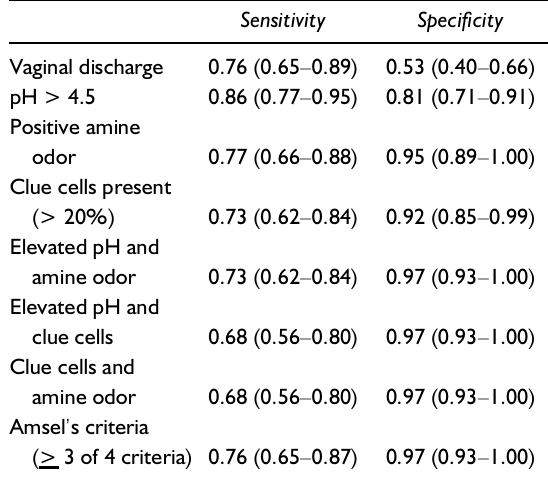
Table 1 Sensitivity and specificity of the criteria for BV, alone or combined ( n =59; 95% CI in